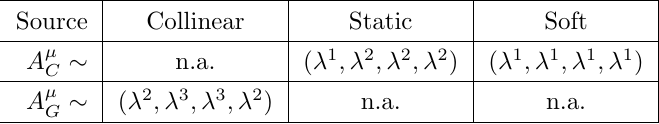
Table 1 . The Glauber/Coulomb (cid:12)led scaling for di(cid:11)erent sources of interaction in matter. insertion, scale as ( (cid:21) 2 ; (cid:21) ), as illustrated in (cid:12)gure 5. If all of the three-momenta components scale as (cid:21) , i.e. q (cid:22) ( (cid:21) 2 ; (cid:21) ) then this corresponds to Coulomb (or potential) gluons. C (cid:24)